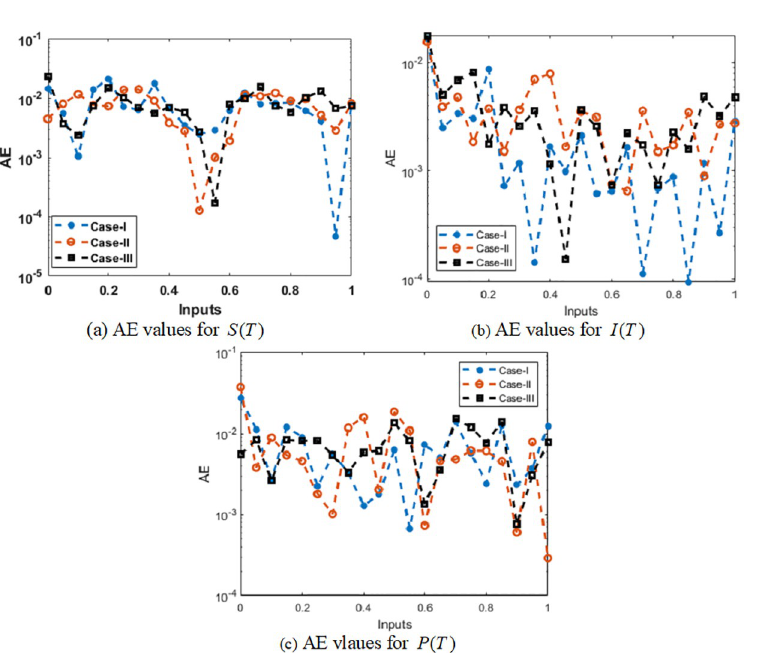
Fig 10. Values of the AE for solving the infection FONPPS. (a) AE values for S ( T ) (b) AE values for I ( T ) (c) AE vlaues for P ( T ).